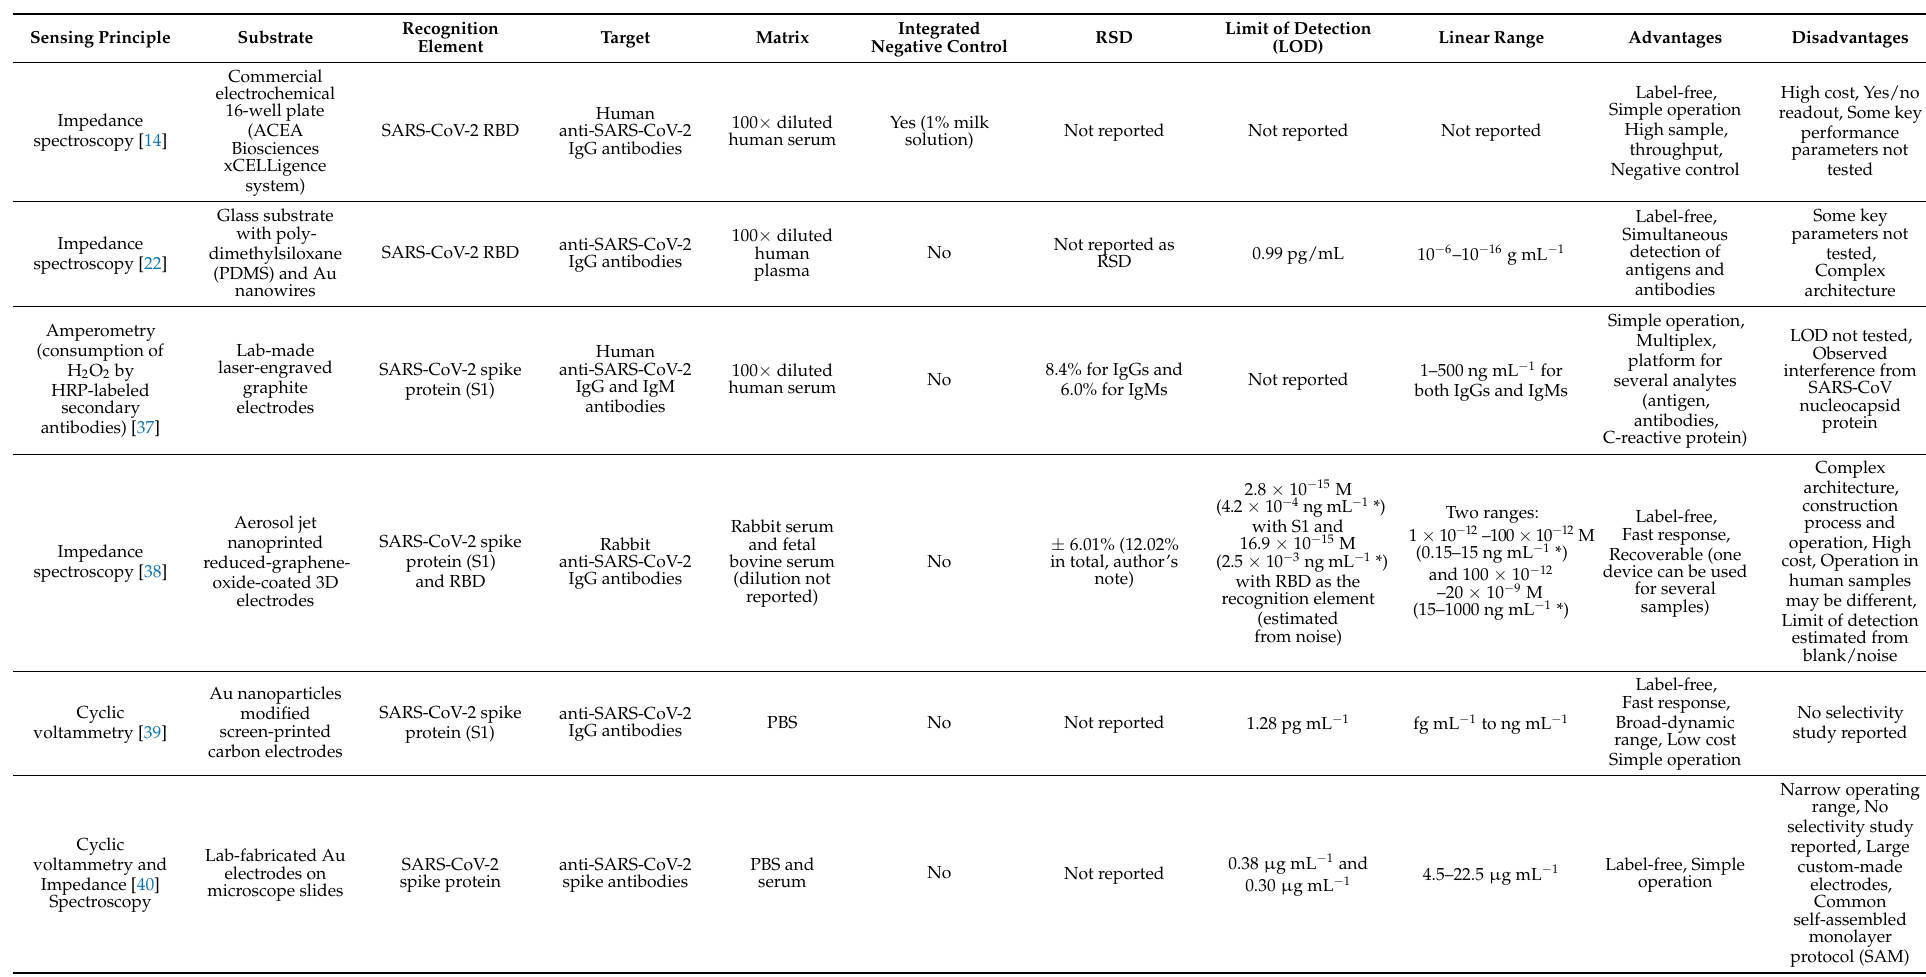
Table 1. Comparison of electrochemical immunosensors for anti-SARS-CoV-2